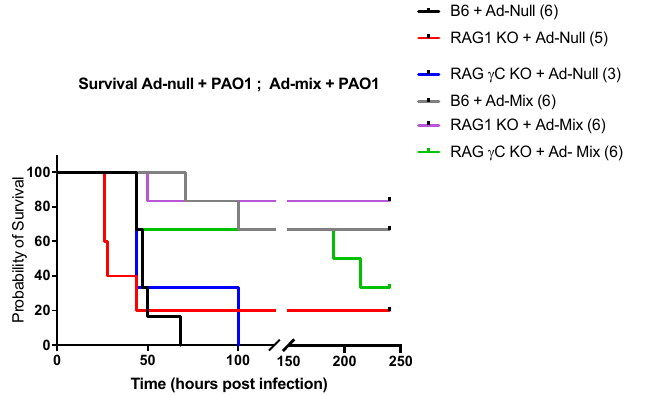
Figure 9. Intra-pulmonary instillation of Adenovirus (Ad)-L1 β + Ad-IL-23 + Ad-IL-7 rescues C57/Bl6 WT, RAG KO and RAG γ C double KO mice from a lethal PAO1 lung infection. C57/Bl6 WT, RAG KO and RAG γ C double KO mice were infected intratracheally, through the oro-pharyngeal route, at day 0 with Ad-null (9.10 7 pfu) or Ad-mix (3.10 7 pfu Ad-L1 β + 3.10 7 pfu Ad-IL-23 + 3.10 7 pfu Ad-IL-7), and 72 h later, mice were infected intra-nasally with 5.10 7 cfu PAO1 and survival was monitored. Numbers in parenthesis represent the number of mice at the start of the experiment. Survival curves were then plotted using Kaplan–Meier curves. Statistical tests were performed using the Log-rank (Mantel–Cox) tests: C57/Bl6 + Ad-null + PAO1 versus C57/Bl6 + Ad-mix + PAO1: p = 0.0005; RAG KO + Ad-null + PAO1 versus RAG KO + Ad-mix + PAO1: p = 0.017; RAG γ C double KO + Ad-null + PAO1 versus RAG γC double KO + Ad-mix + PAO1: p = 0.08.